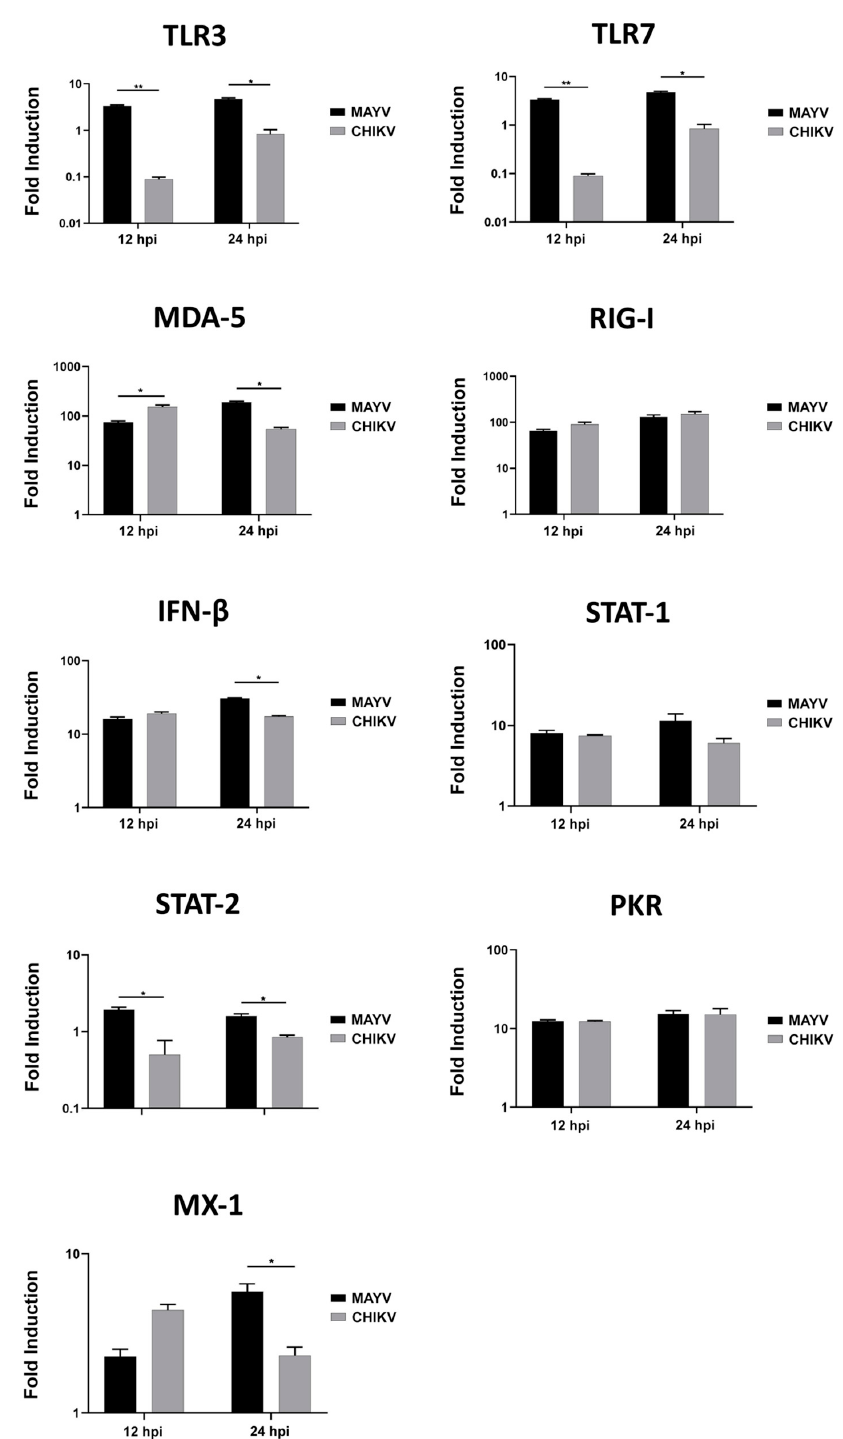
Figure 6. Modulation of antiviral gene expression by MAYV and CHIKV in human astrocytes. Astrocytes were cultured in the absence or presence of MAYV or CHIKV at an MOI of 5 and RNA was extracted 12 and 24 hpi, and innate immune gene expression was quantified by RT-PCR. Glyceraldehyde-3-phosphate dehydrogenase (GAPDH) was used for normalization. Modulation of antiviral response genes following MAYV or CHIKV infection is expressed as a function of that with mock-infected cells. The mean values are represented by each point, and two experiments were done, each performed in triplicate. Fold induction of transcript is shown. Wilcoxon–Mann–Whitney test was performed with a p -value significant when * p < 0.05, ** p <